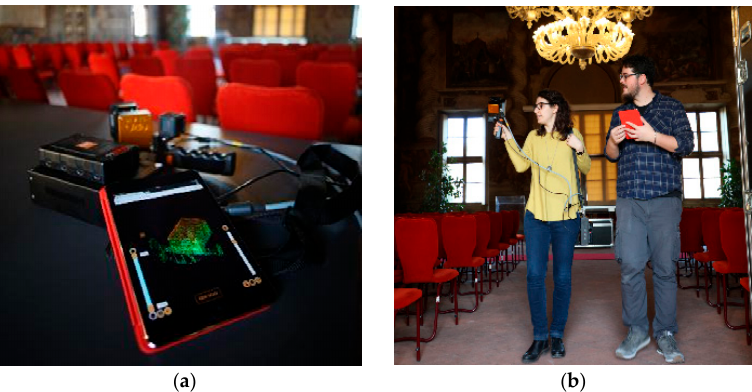
Figure 4. The ZEB Revo Real Time Mobile Mapping System (RT MMS) by Geo Simultaneous Localization and Mapping (GeoSLAM): ( a ) The data logger, the rotating head and the Go Pro mounted above and the IPad Pro employed for the real-time view during the acquisition phase; and; ( b ) Operators scanning the Great Salon with the instrument.